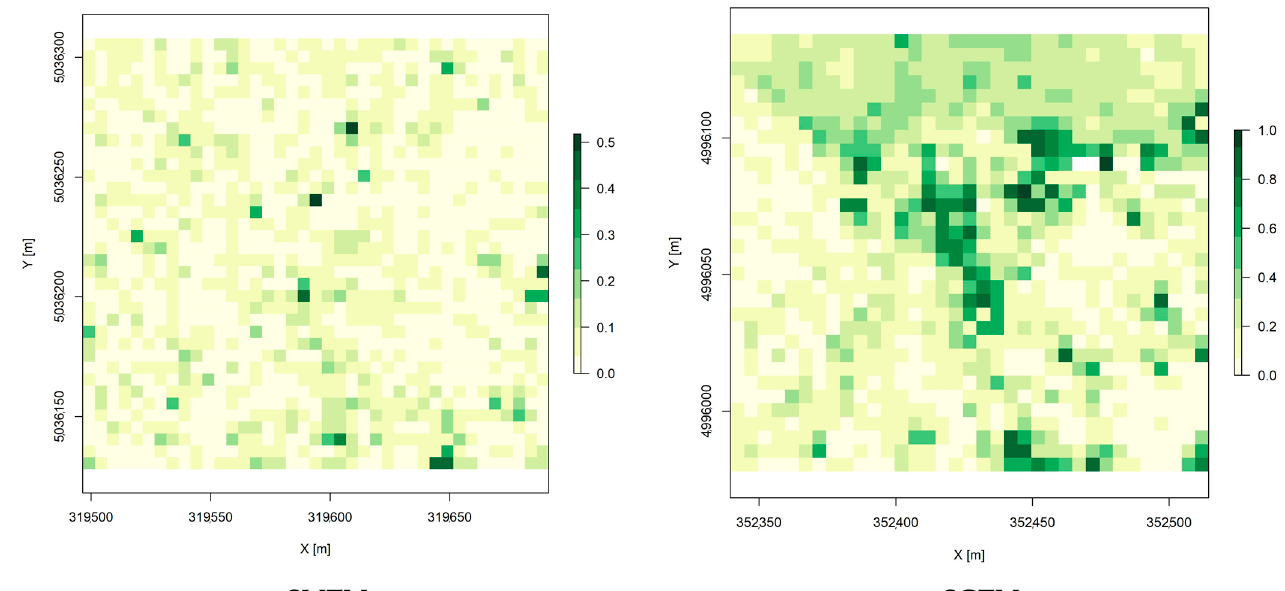
Figure 9. Mapping of the shrub layer (5 × 5 m pixel)—undergrowth return fraction.